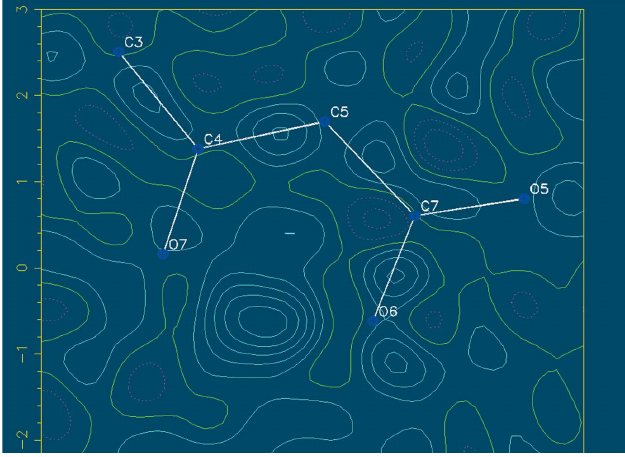
Figure 2 Difference-Fourier electron-density map showing the electron density associated with the H atom involved in the O6—H6 (cid:2)(cid:2)(cid:2) O7 hydrogen bond.